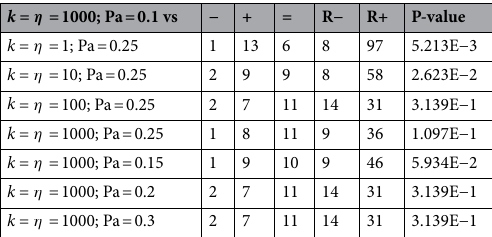
k = η = 1000; Pa = 0.1 vs − + = R− R+ P-value k = η = 1; Pa = 0.25 k = η = 10; Pa =